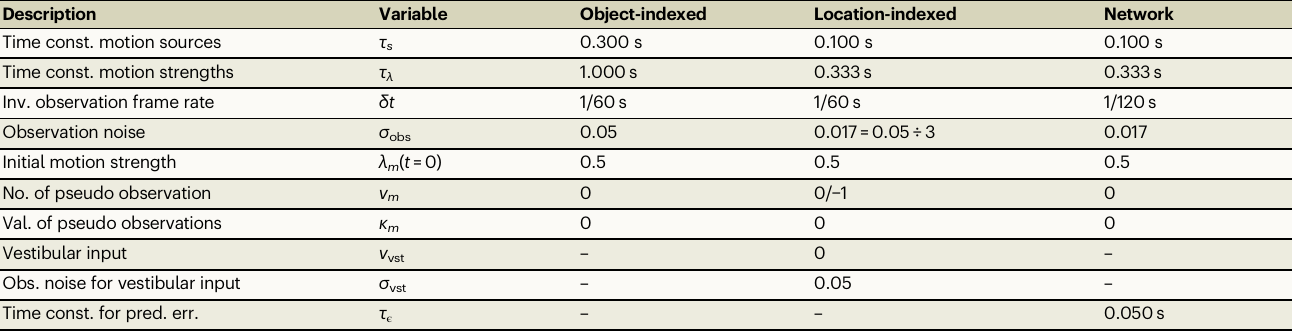
Table 1 | Default parameters of the computer